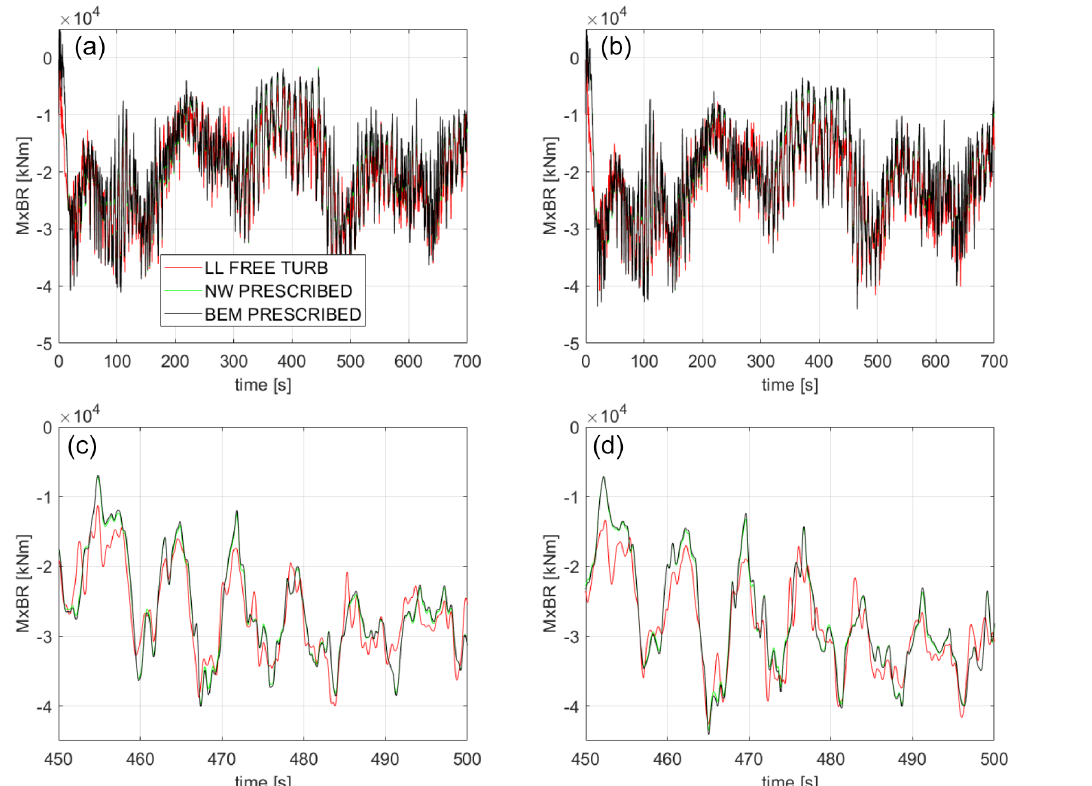
Figure 17. Flapwise root bending moment for MxBR (a,c) baseline and (b,d) optimized design. (a,b) Full simulation time and (c,d) zoom- in for a 50s time interval.